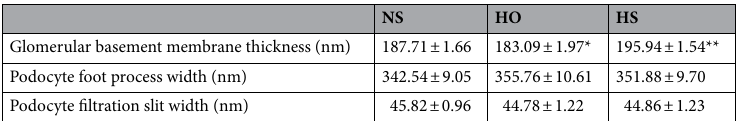
Table 1. Renal morphology measurements in rats after elution with normal salt (NS), high osmolarity (HO) or high salt (HS). Measurements from glomerular capillaries from 5 rats/elution (capillaries; NS n = 103, HS n = 143, and HO n = 133). * P<0.05, **P<0.01 compared to NS